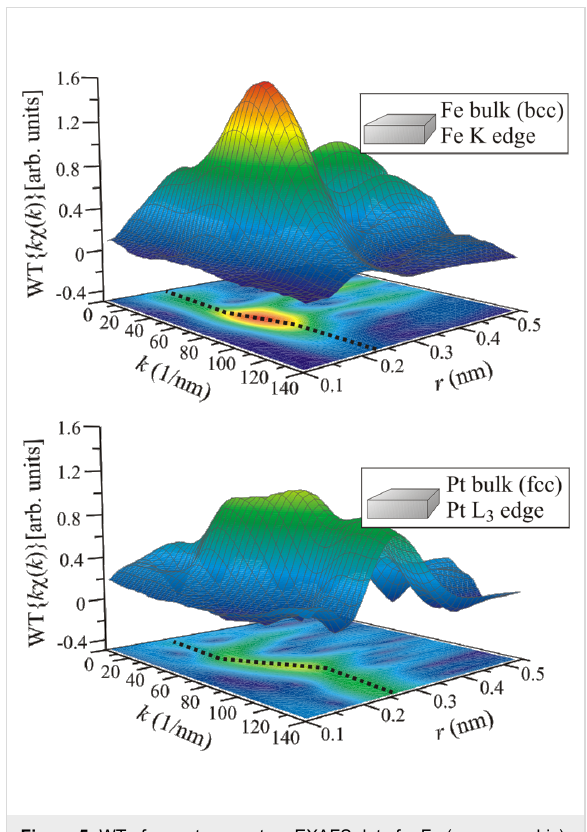
Figure 5: WT of room temperature EXAFS data for Fe (upper graphic) and Pt (lower graphic) reference samples measured at the Fe K and Pt L 3 absorption edge,